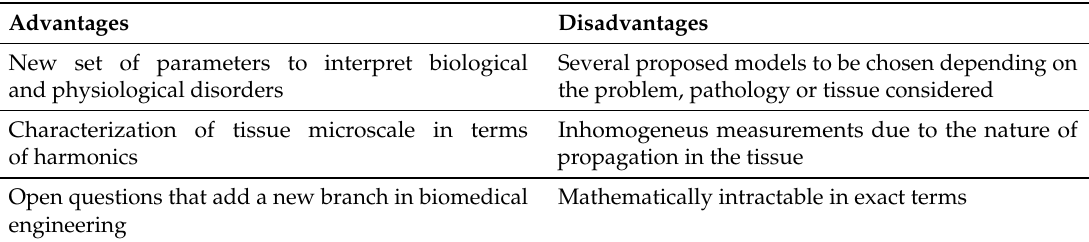
Table 3. Summary of the current state of implementation of nonlinearity in the quantification of soft tissue mechanical